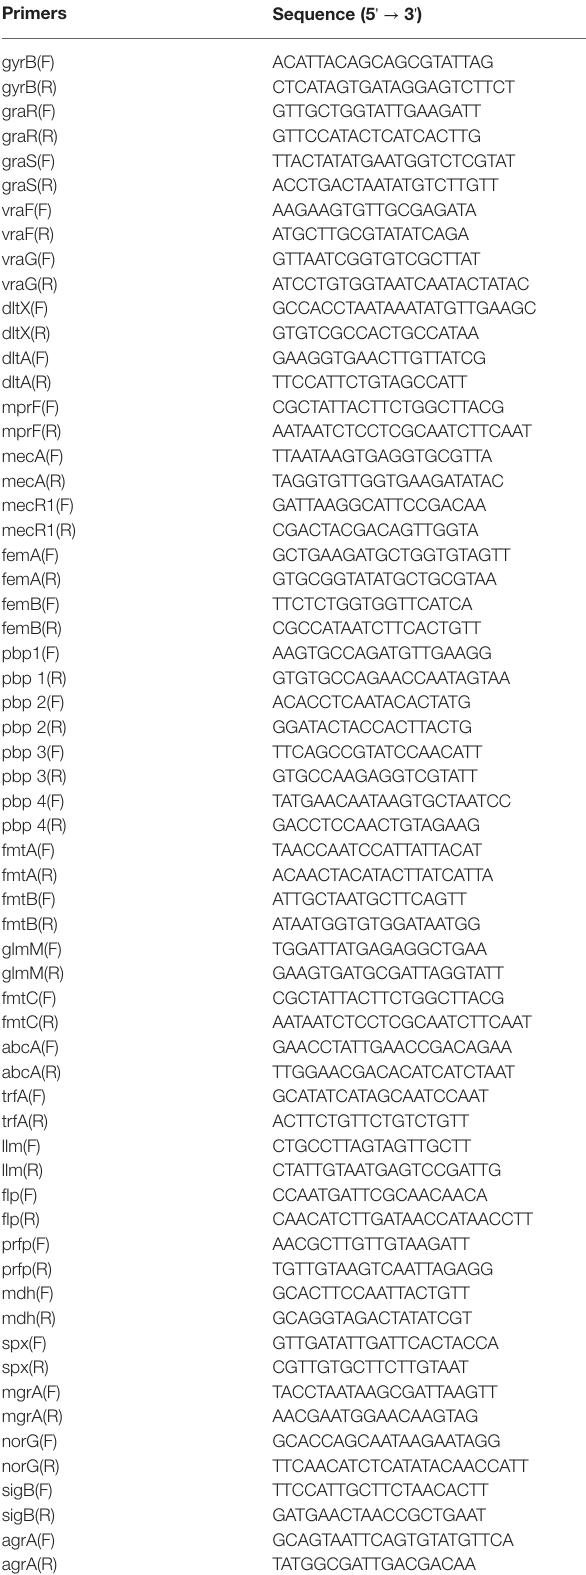
TABLE 1 | Primers used in this